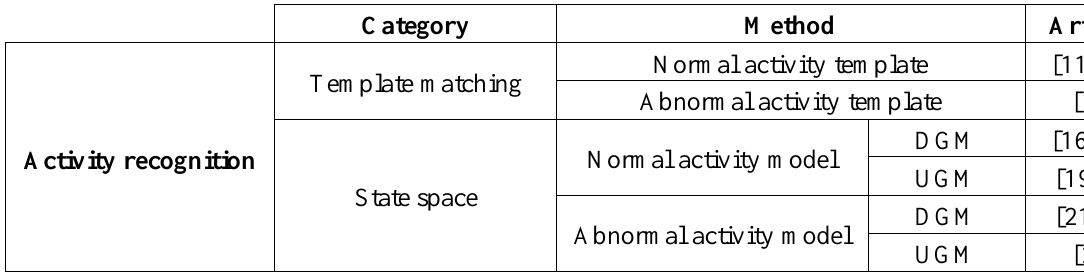
Table 1. Methods for human activity